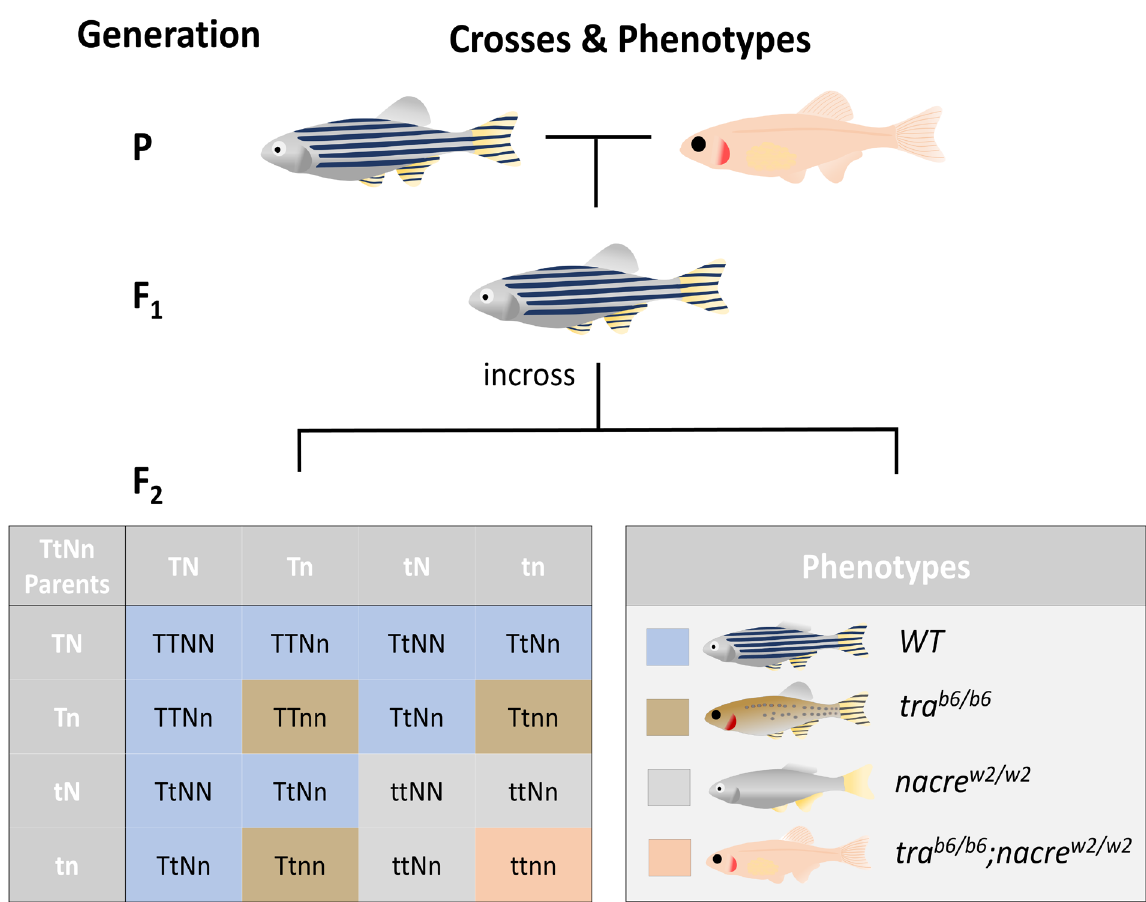
Figure 2. Theoretical ratios of crosses between wild-type and transparent zebrafish. The earliest possible transparent phenotype after a wild-type and TraNac fish have been bred (P generation) is the second generation (F2). However, at that point, only 6.25% of all fish will theoretically be transparent, due to the genetic inheritance pattern of both tra and nacre alleles being passed on in their mutated form ( tra b6 & nacre w2 ). As indicated in the Punnet square, there are 16 possible combinations of genes (T indicating functional tra allele and t represents mutated tra b6 , while N indicates functional nacre and n mutated nacre w2 ). The 16 possible combinations can result in 4 different phenotypes WT pattern, tra pigmented pattern, silvery nacre , transparent TraNac with the associated ratio of 9:3:3:1. nac = nacre, tra = transparent , WT =